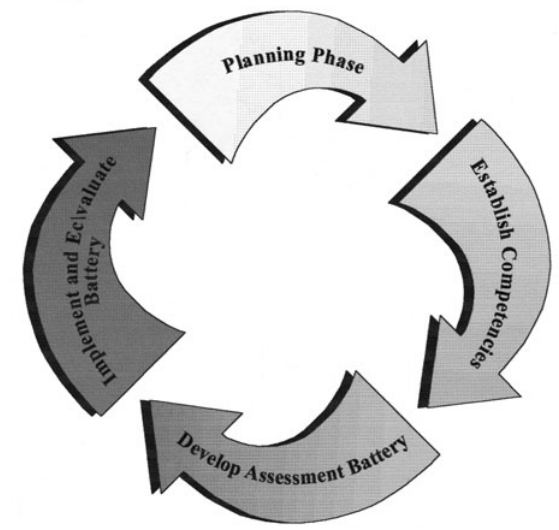
Figure1:Designinga competency-based